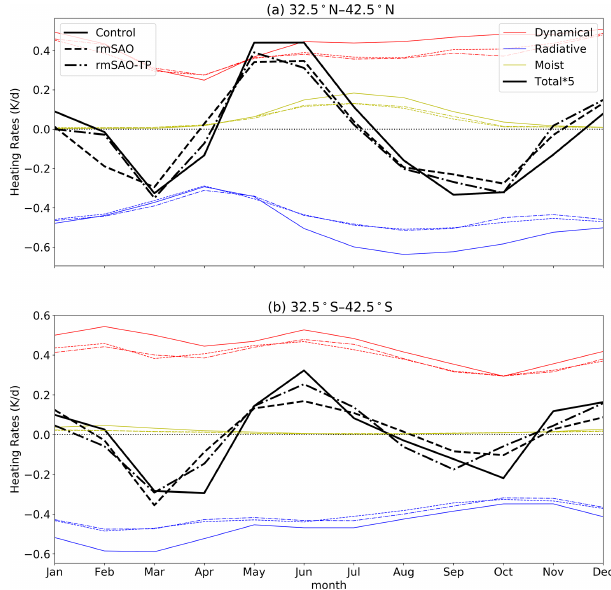
Figure 9. Annual cycle of the heating rates at 200hPa averaged around the Northern Hemisphere mid-latitudes 32.5–42.5 ◦ N (a) and the Southern Hemisphere mid-latitudes 32.5–42.5 ◦ S (b) . The red, blue and yellow lines indicate the heating rates related to dy- namics, radiation and condensation processes, respectively. The to- tal heating rates, which are the sum of the dynamical, radiative and moist heating rates, are illustrated by black lines. The solid, dashed and dotted-dashed lines indicate data from the control, rmSAO and rmSAO-TP simulations,